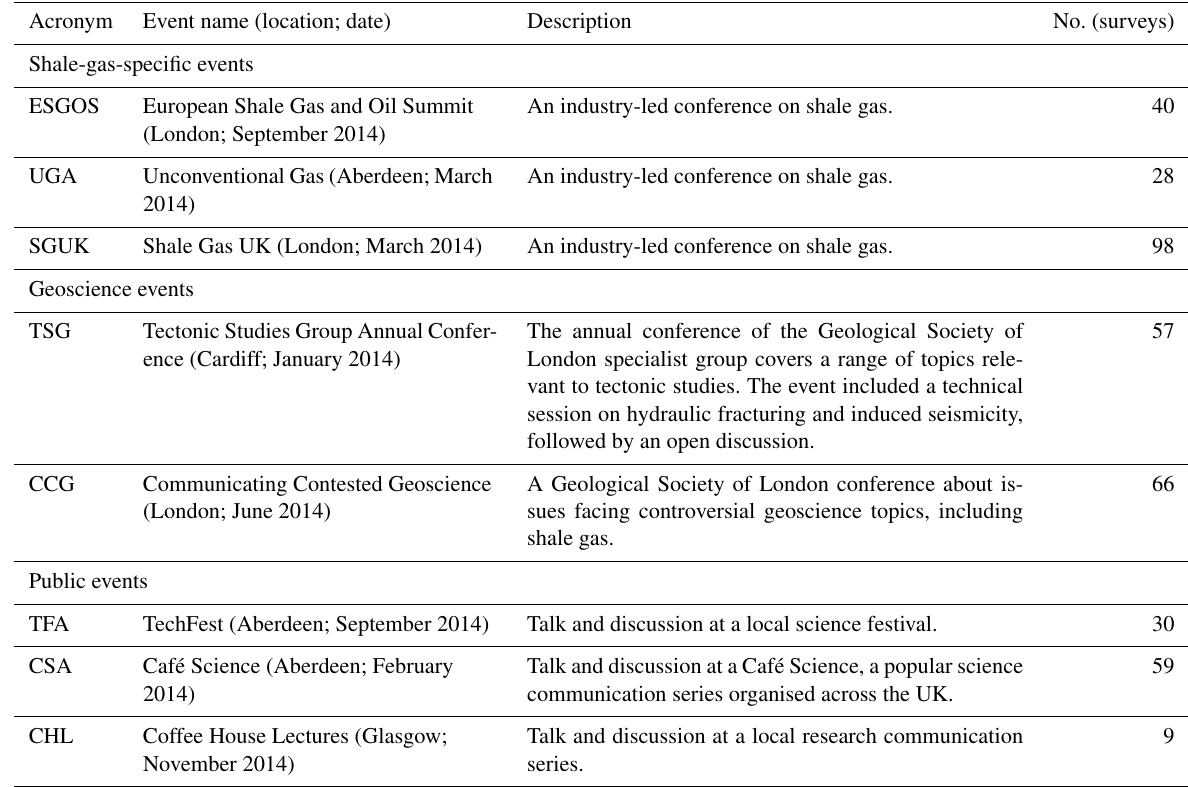
Table 3. The events where attendees were invited to anonymously complete surveys. Public events were generally small local